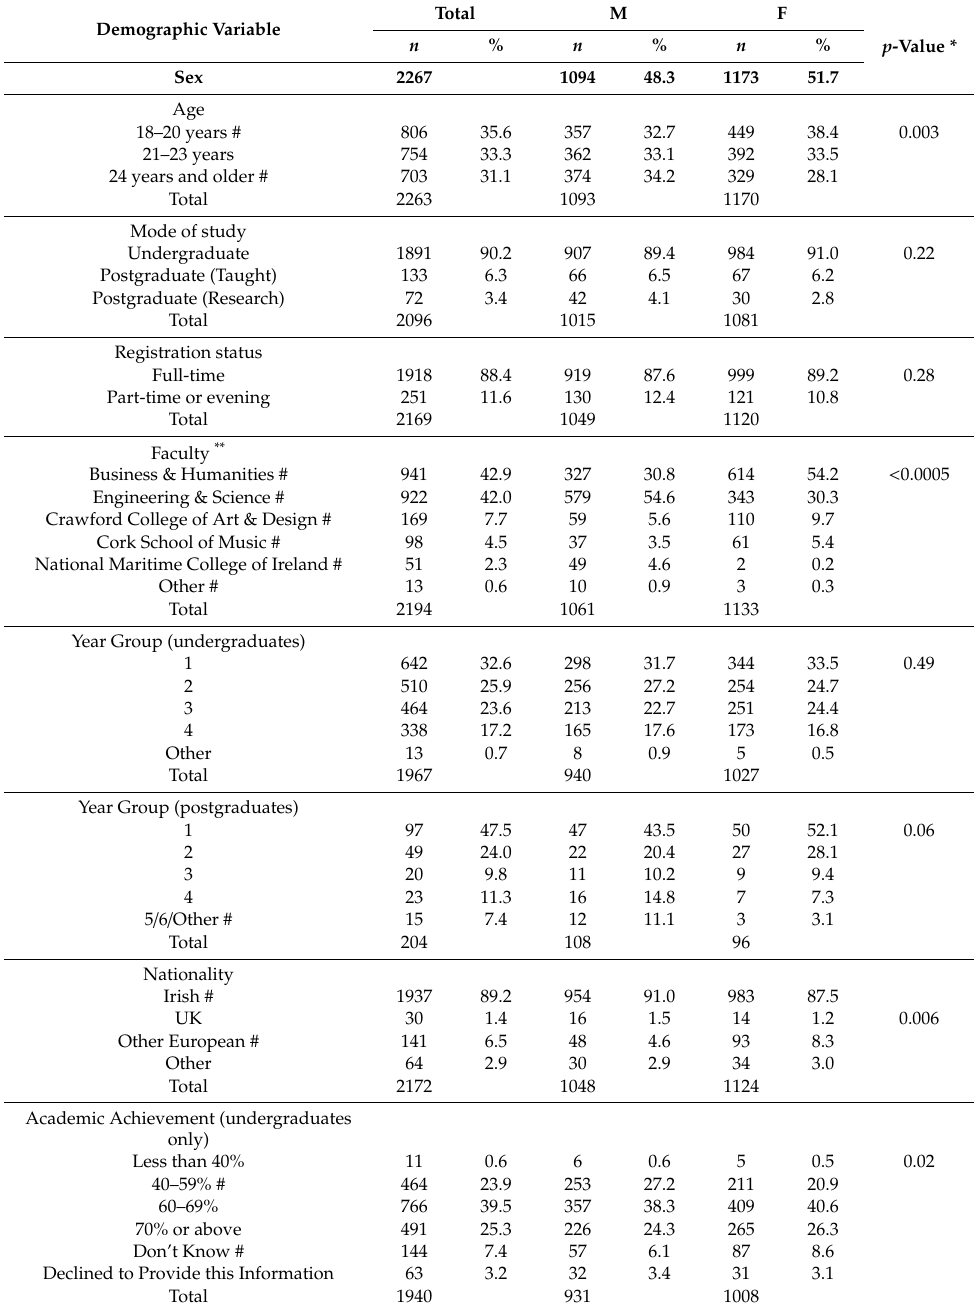
Table 1. Demographic Characteristics of Participants by